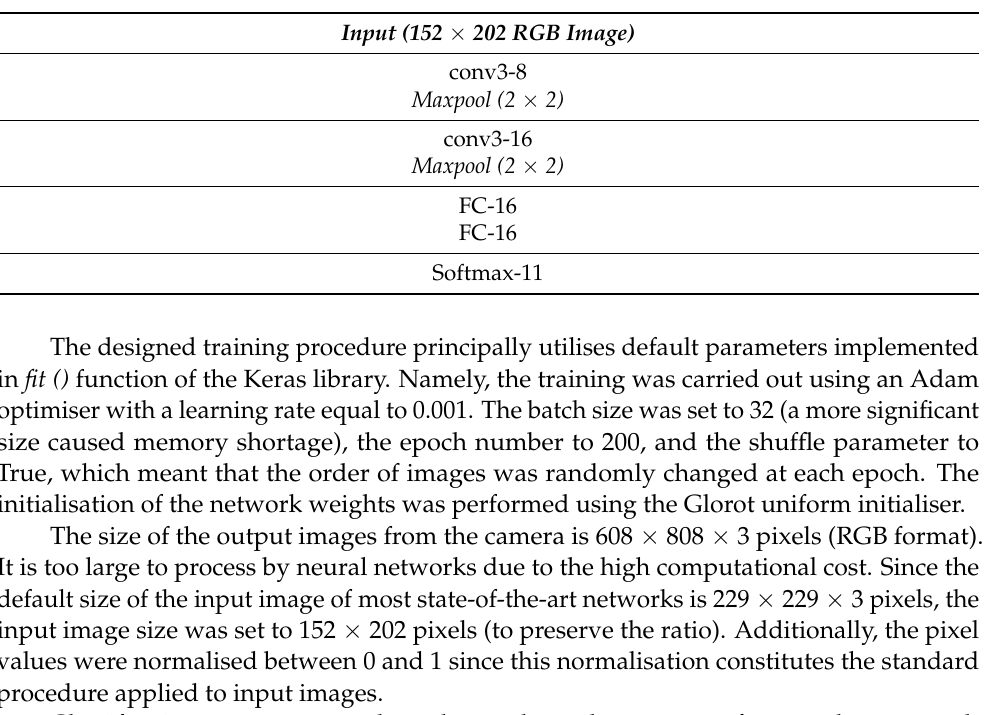
Table 2. Baseline model architecture (conv A - B means a convolutional layer with B filters of an A x A size, FC- C is a fully connected layer with C neurons, and Softmax- D is a softmax layer with D outputs).